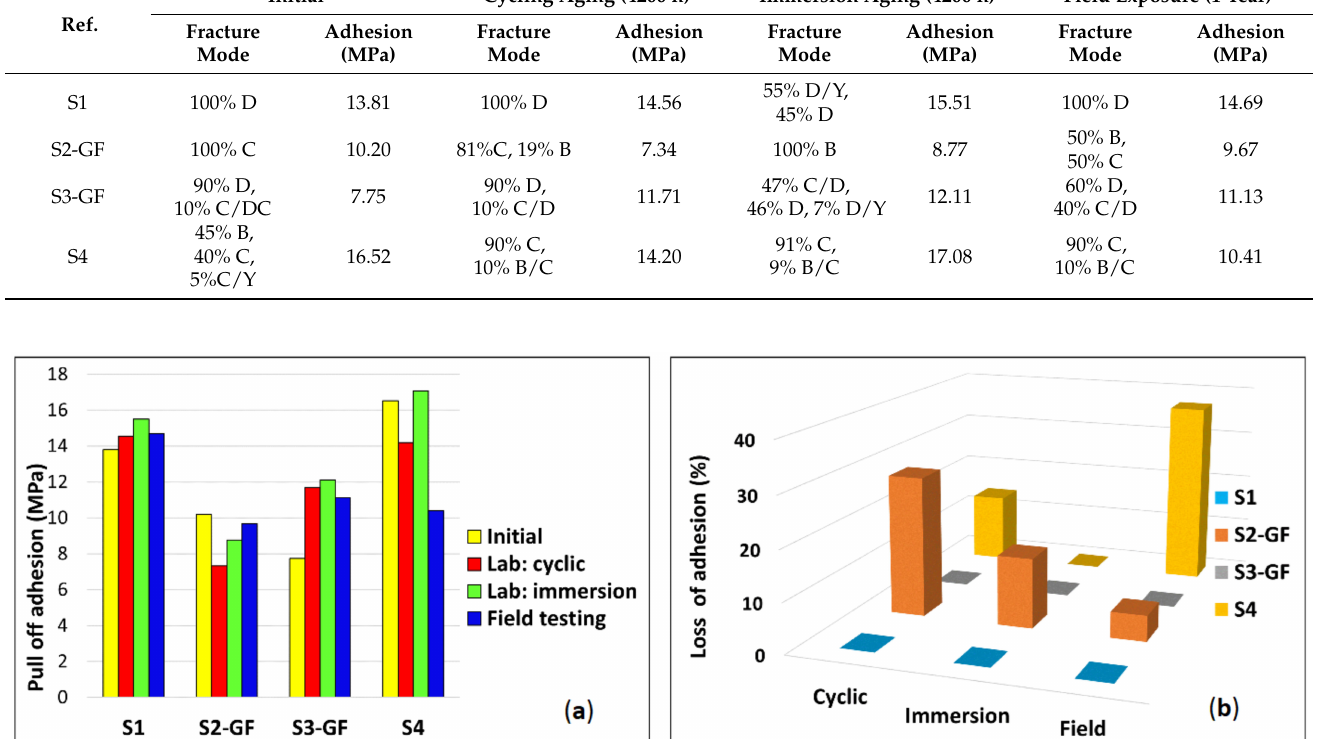
Figure 6. ( a ) Pull-off adhesion strength of the coatings for splash zone before and after laboratory aging and field exposure. ( b ) Loss of adhesion of the coating systems after aging and field